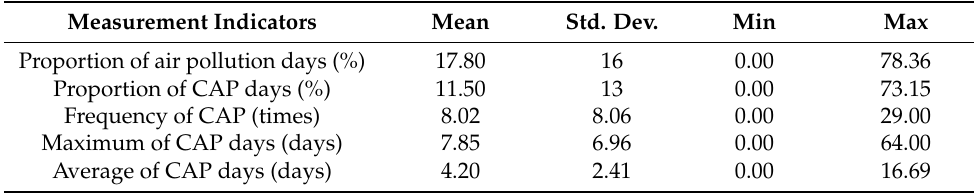
Table 2. Descriptive statistics of CAP-related measurement indicators in